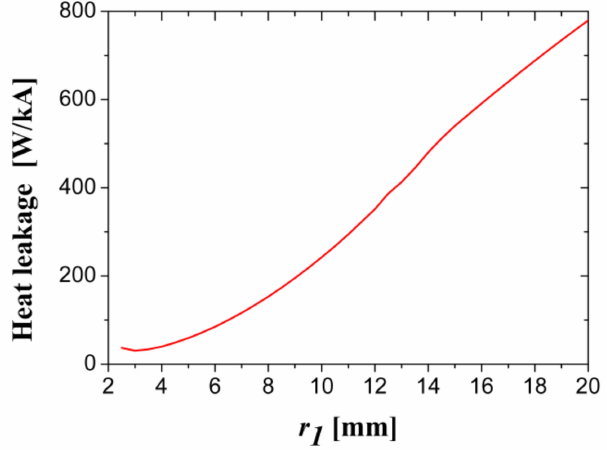
Figure 6. The effect of radius of the copper leads r 1 on the cold end heat leakage of PCLs. Then, we change the initial values for different dimensional parameters slightly, and through parametric sweep iteration, we obtain another two sets of optimal parameter sizes corresponding to a minimum heat leakage of PCLs, as shown in Table 3 (the details of the iteration progress are listed in Appendix A.2). Obviously, compared with the traditional copper current leads, the reduction rate of heat leakage at the cold end of PCLs exceeds 30%. That shows a huge advantage in saving energy for